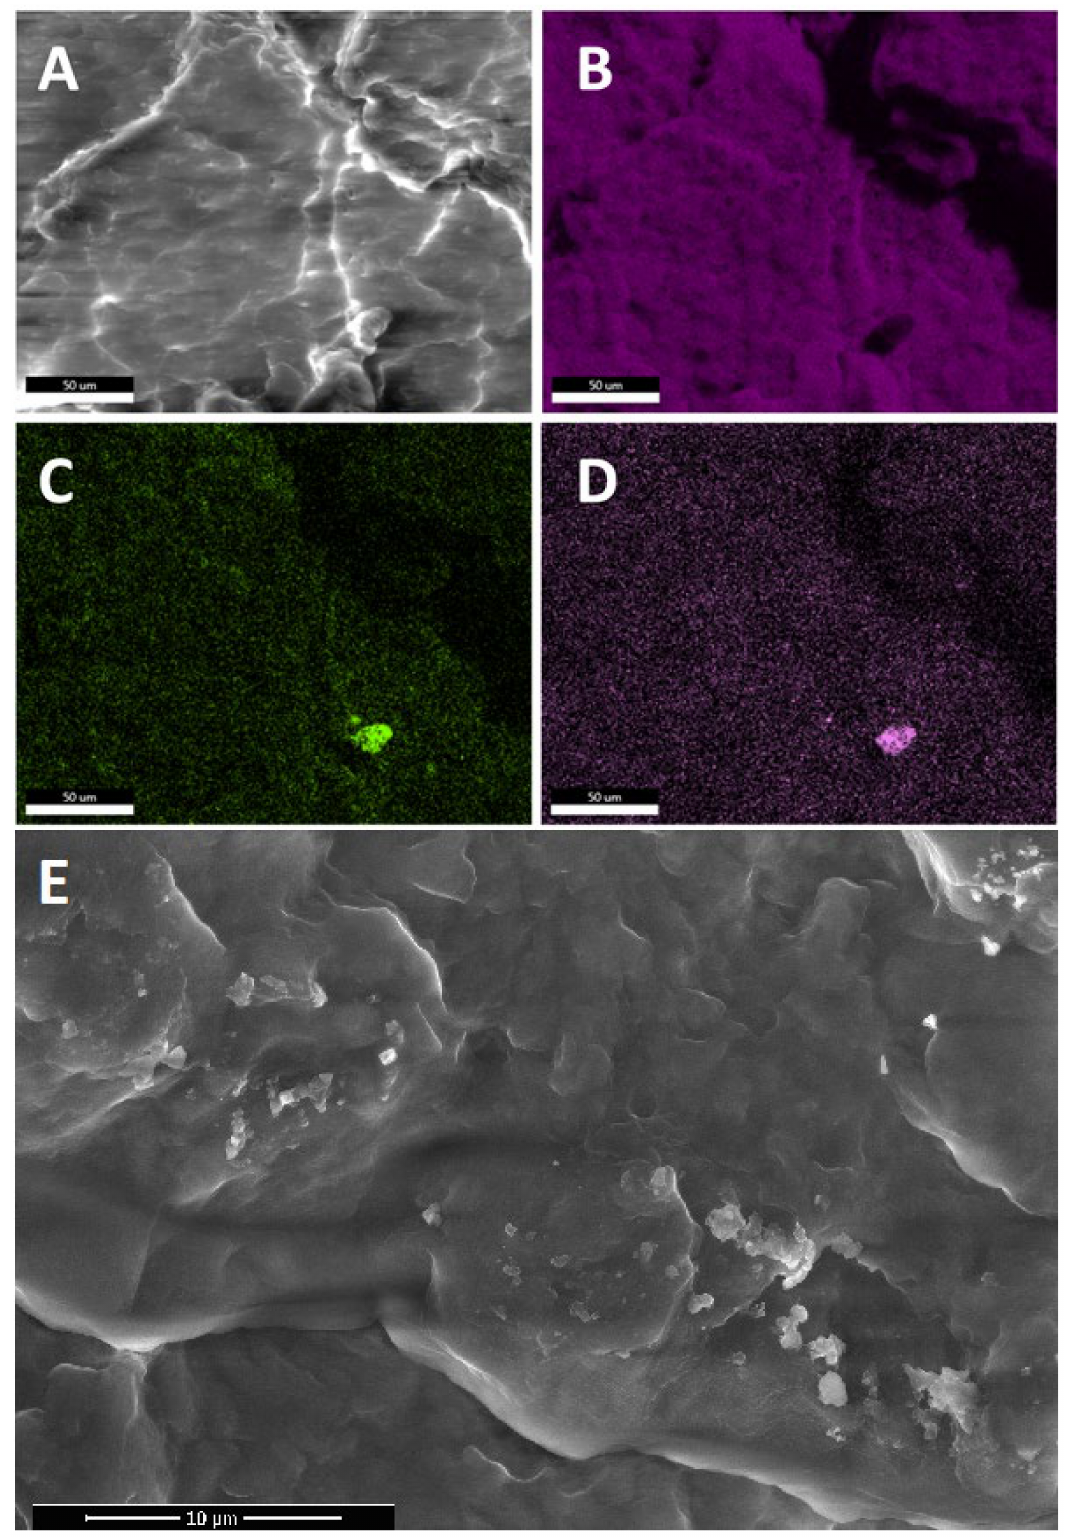
Figure 3. SEM ( A , E ) and EDS ( B – D ) images of 1% SS-Vi/iPP composite. ( A )—field of view SEM, ( B )—carbon EDS, ( C )—oxygen EDS, ( D )—Silicon EDS, ( E )—high resolution